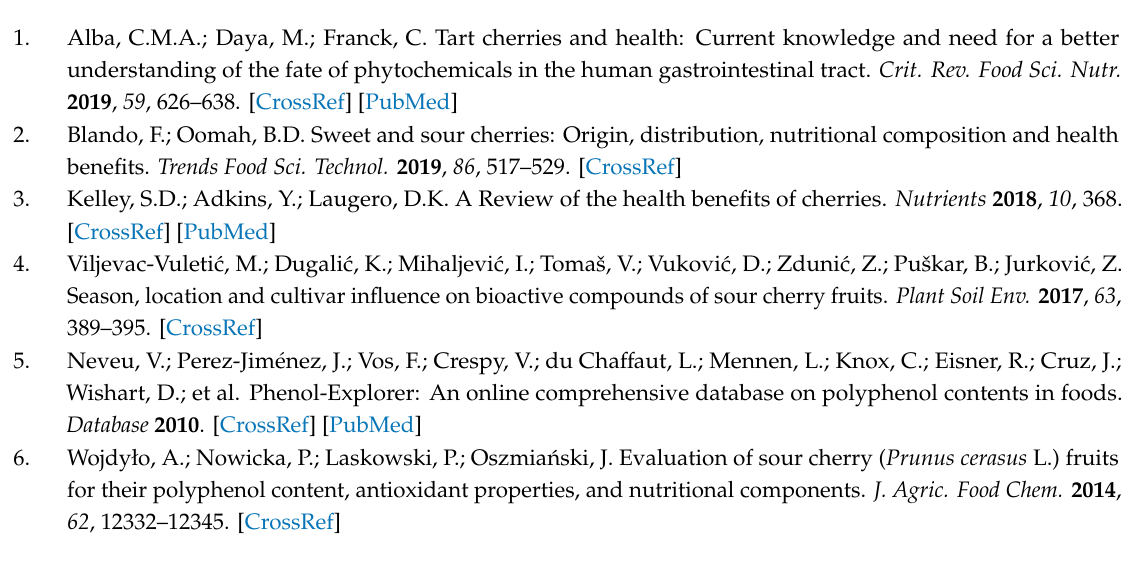
Table S3: Phenolic acid profile (mg / 100 g FW) in fruit of 21 sour cherry cultivars; Table S4: Flavan 3-ol profile (mg / 100 g FW) in fruit of 21 sour cherry